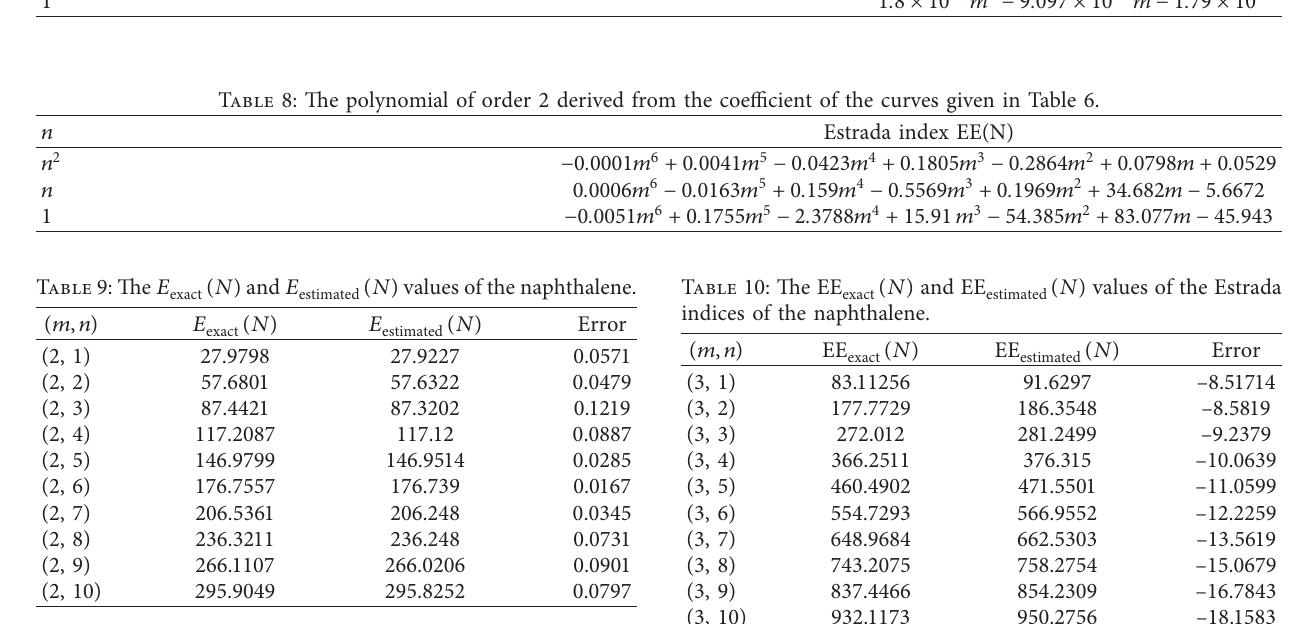
Table 7: The polynomial of order 2 derived from the coefficient of the curves given in Table 6. n Energy (E(N)) n 2